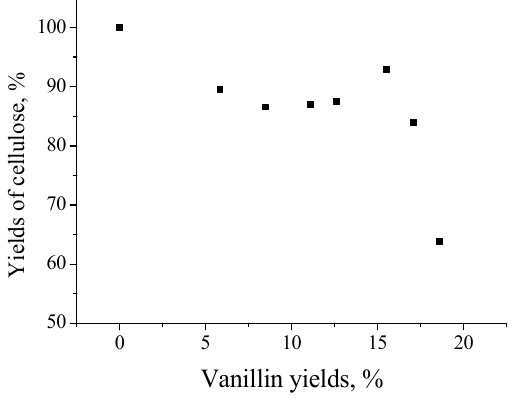
Figure 5. Vanillin and cellulose yields in pine wood catalytic oxidation in alkaline aqueous media at 160 °C [121].